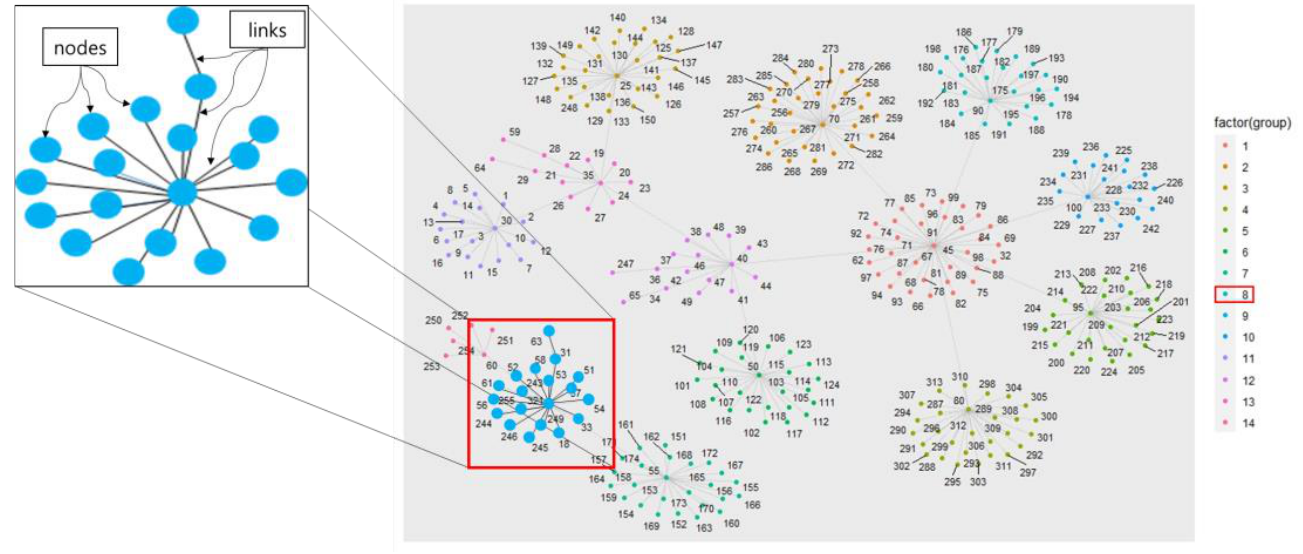
Figure 3. Structure of the network.